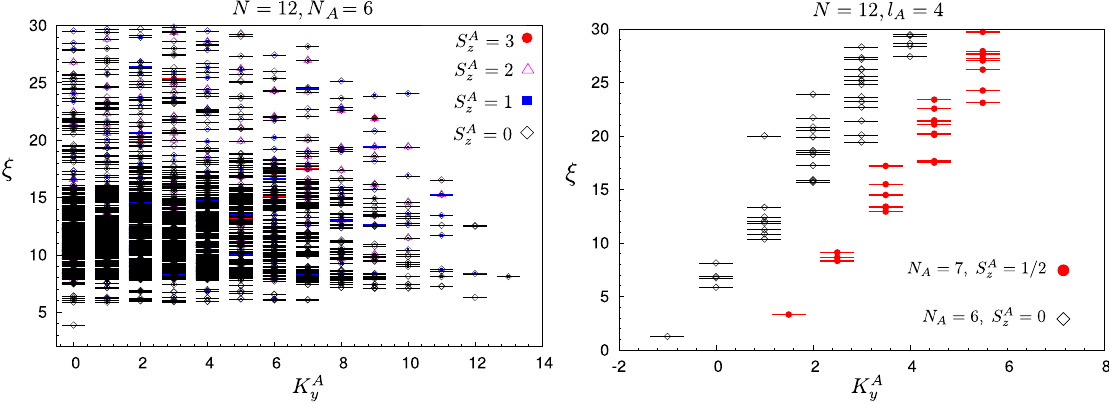
FIG. 9. PES (left panel) and OES (right panel) for the NASS ν ¼ 4 = 3 state. The system contains N ¼ 12 bosons on a finite cylinder with aspect ratio 1. For PES, the subsystem A contains N A ¼ 6 particles, and PES is plotted as a function of momentum K A y of subsystem z component of spin in part A , as indicated in the inset. For OES, the A . The states are labeled by different values of S A z , the total subsystem A contains l A ¼ 4 orbitals, where we show data for N A ¼ 6 and N A ¼ 7 . The spectrum is resolved as a function of momentum K A y of subsystem A